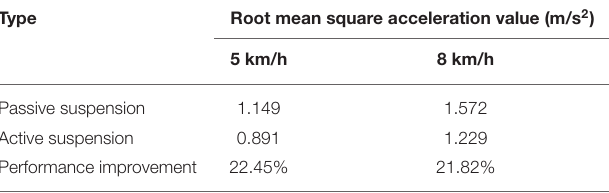
TABLE 6 | Different root mean square values of vibration acceleration when driving under sand-gravel road